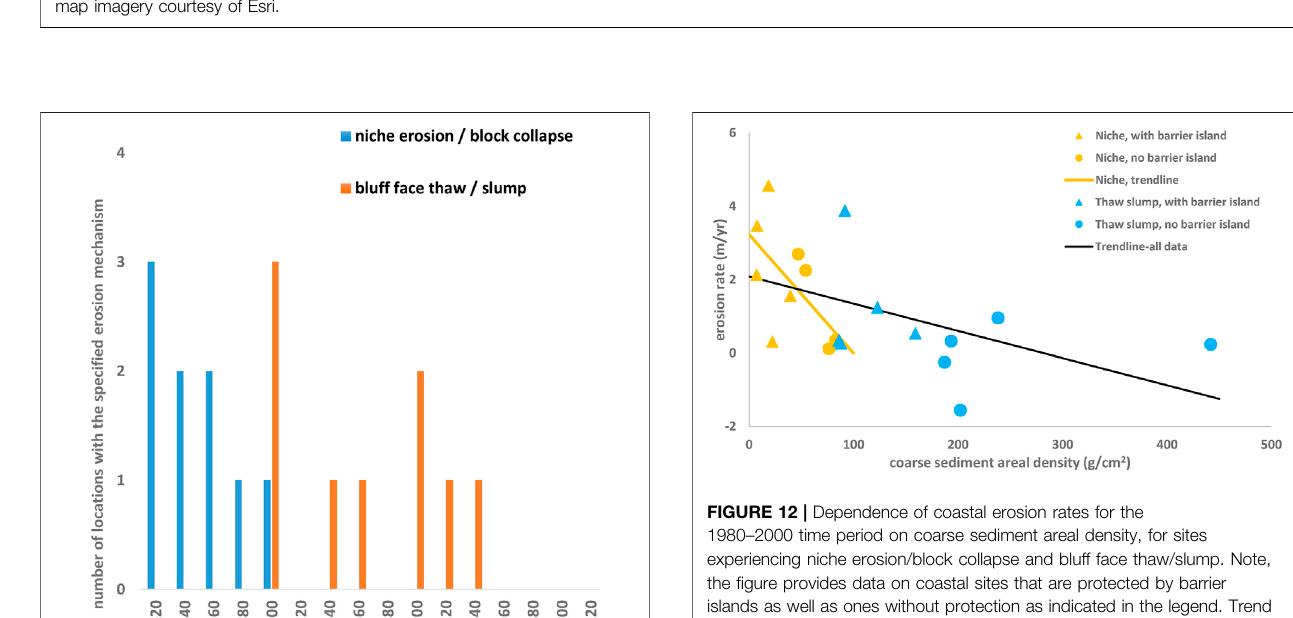
FIGURE 10 | Map of the north coast of Alaska showing the locations of the coastal sites studied as well as the erosion mechanism attributed to those sites. Base map imagery courtesy of Esri.